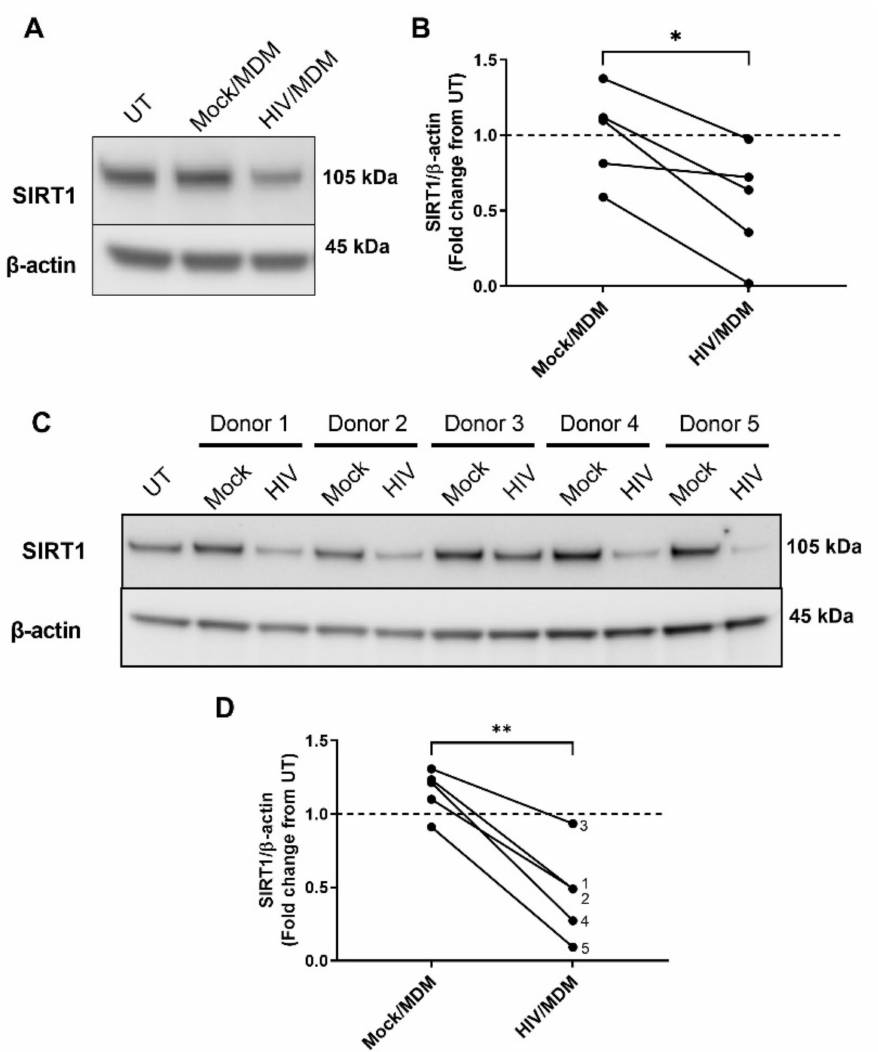
Figure 4. Protein lysates were collected from rat neuronal cultures after 16 h treatment with Mock or HIV/MDM supernatants. Representative blots are shown ( A ). Treatment with HIV/MDMs decreased levels of SIRT1 when compared to Mock/MDMs across five different preparations of primary rat cortical neurons ( B ). Statistical significance was calculated using paired t test. * Represents p < 0.05 ( n = 5). Protein lysates were collected from primary rat neuronal cultures after 16 h treatment with five different sets of Mock and HIV/MDM supernatants. Representative blots are shown ( C ). Treatment with HIV/MDMs significantly decreased SIRT1 when compared to Mock/MDMs. Each number represents the macrophage donor pair ( D ). Statistical significance was calculated using paired t test. * Represents p < 0.05, ** p < 0.01 ( n = 5). Dotted line represents untreated